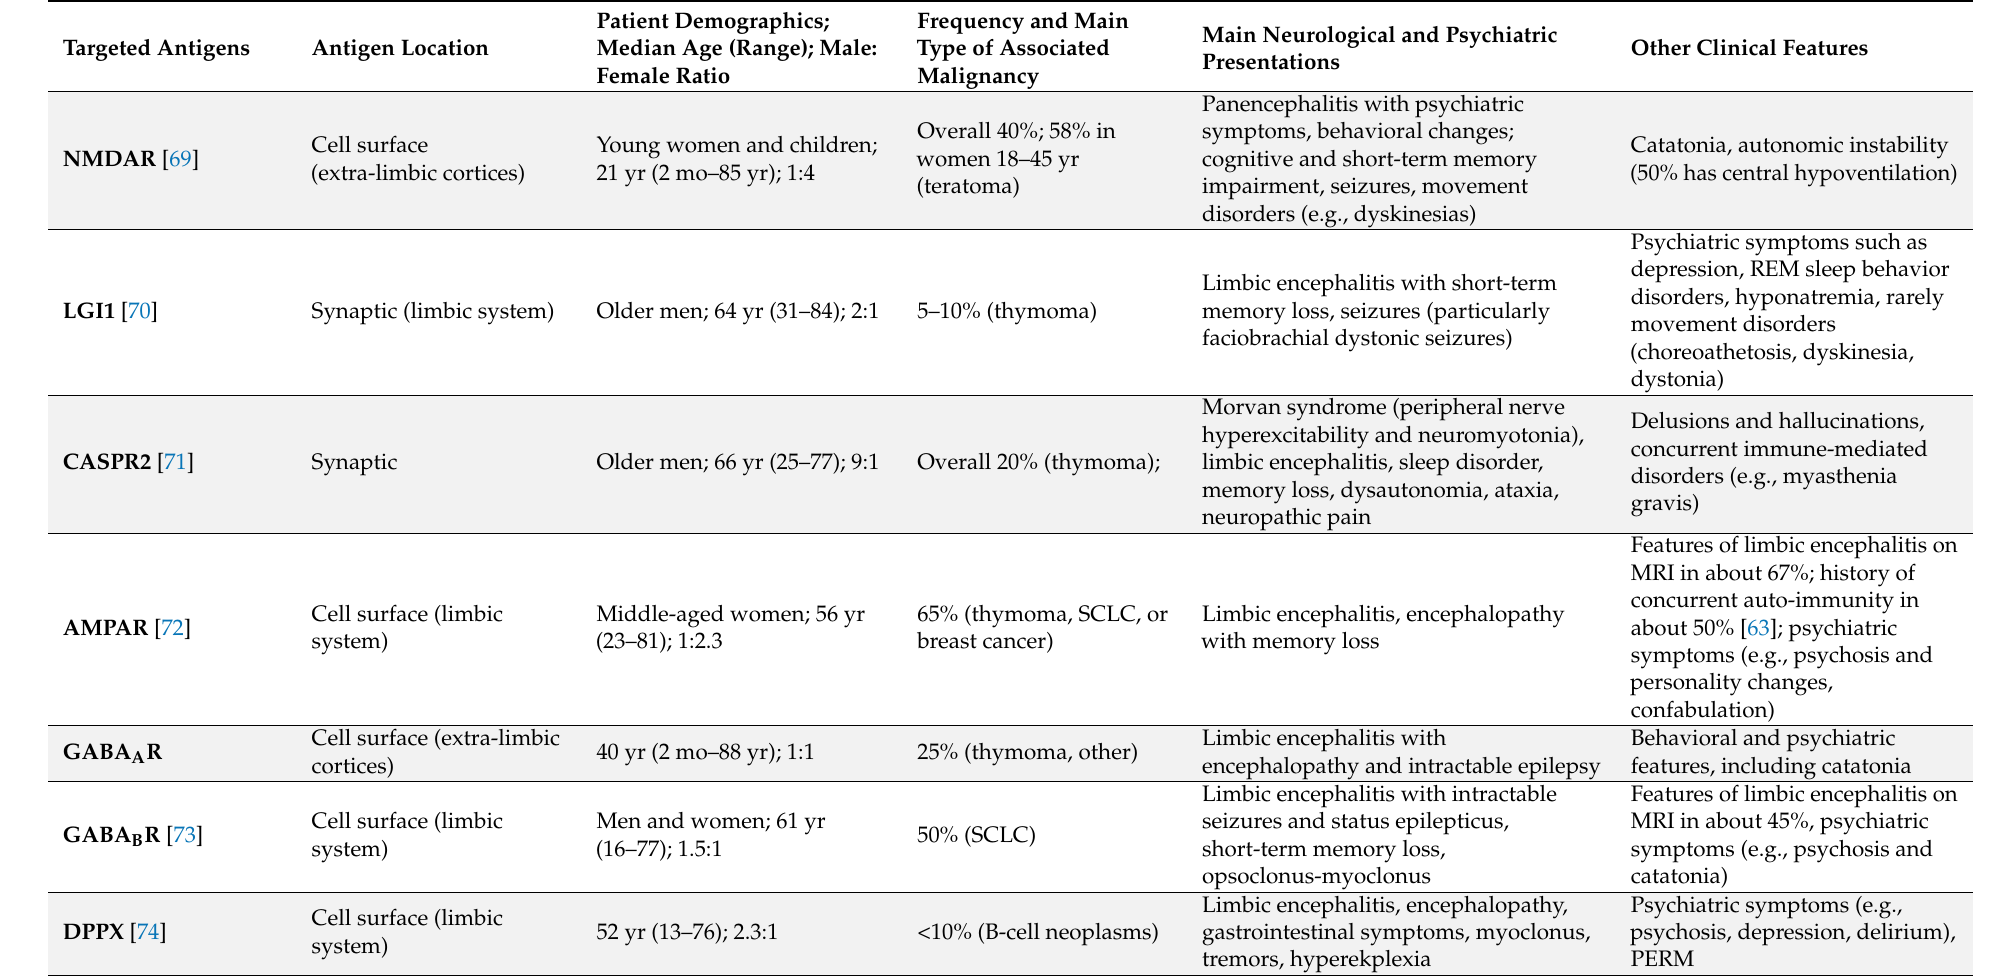
Table 1. Clinical and immunologic features of common types of autoimmune encephalitis